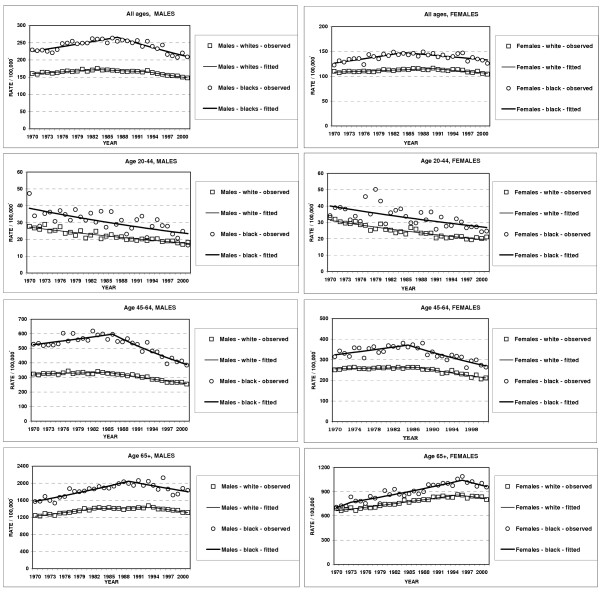
Cancer mortality time trends, all sites, Ohio, 1970–2001, by race # – Age-adjusted mortality rates (World Standard Population).